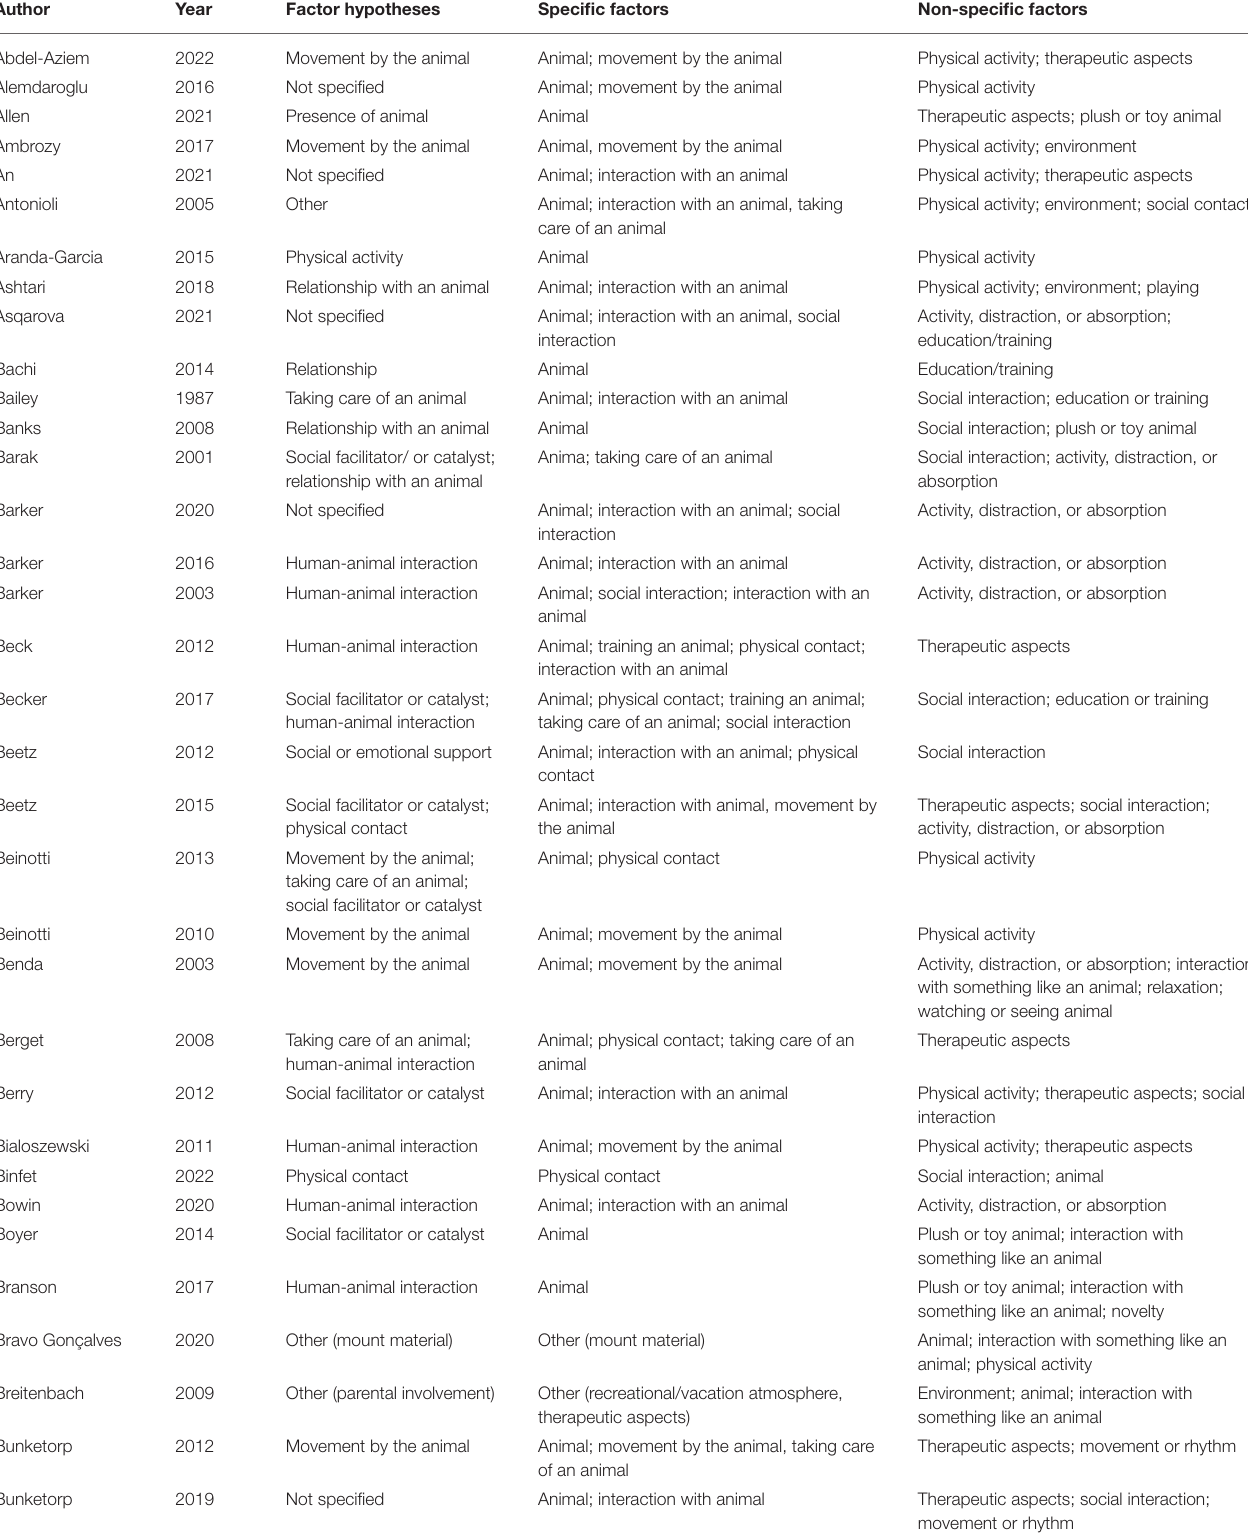
TABLE 2 | Identified factor hypotheses, specific and non-specific factors of each